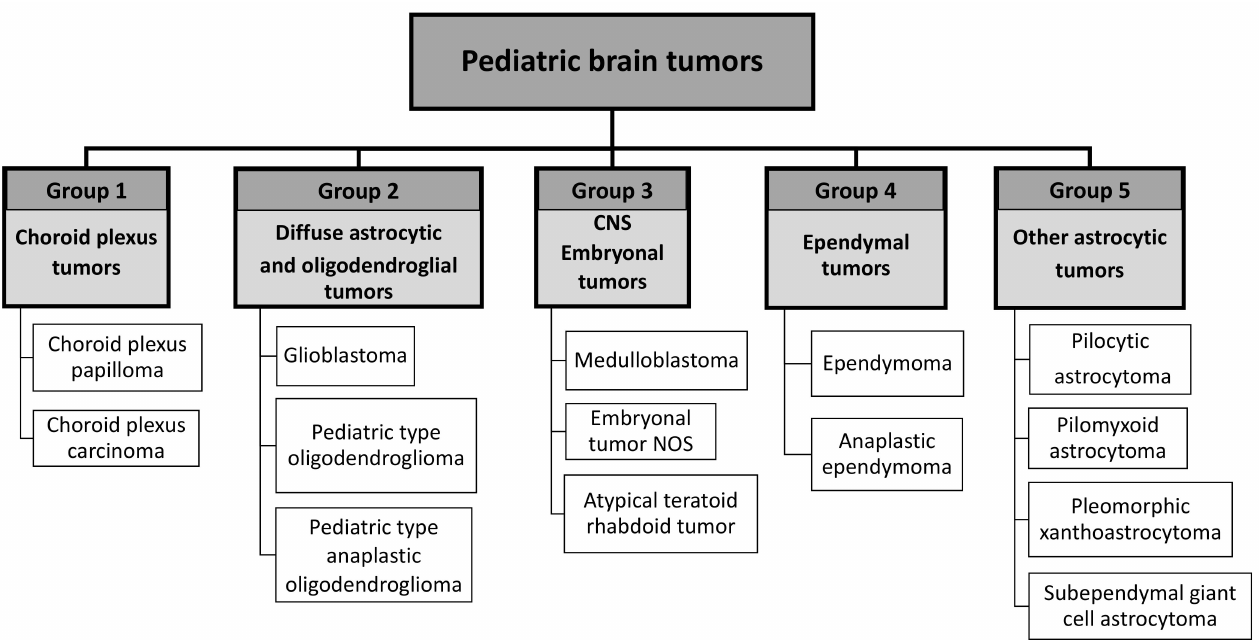
Figure 10. A diagram showing the division of examined pediatric brain tumor groups. Based on the histochemical staining and histopathological assessment, the tumor samples tested for ShcA, Ras, and TrkB proteins in this study were classified into the groups shown in the presented chart and named according to the newest WHO indications. This picture intends to help analyze the data and interpret the results of the experiments presented in the